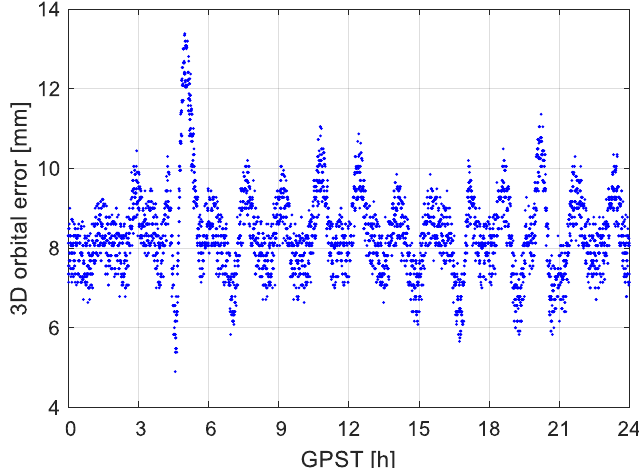
Figure 12. 3D orbital errors not applying the antenna attitude information. The IGS final products were used for observations with a duty-cycle of 100%, a sampling interval of 10 s, and a mean satellite number of 9.